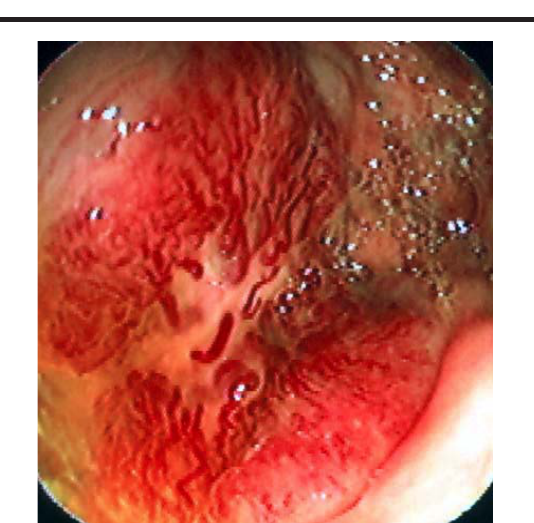
FIGURE 4 - Colonoscopic view of rectal varix (GII). TABLE 2 - Frequencies of vascular abnormalities: colonoscopic findings in Group II Colonic vascular abnormality